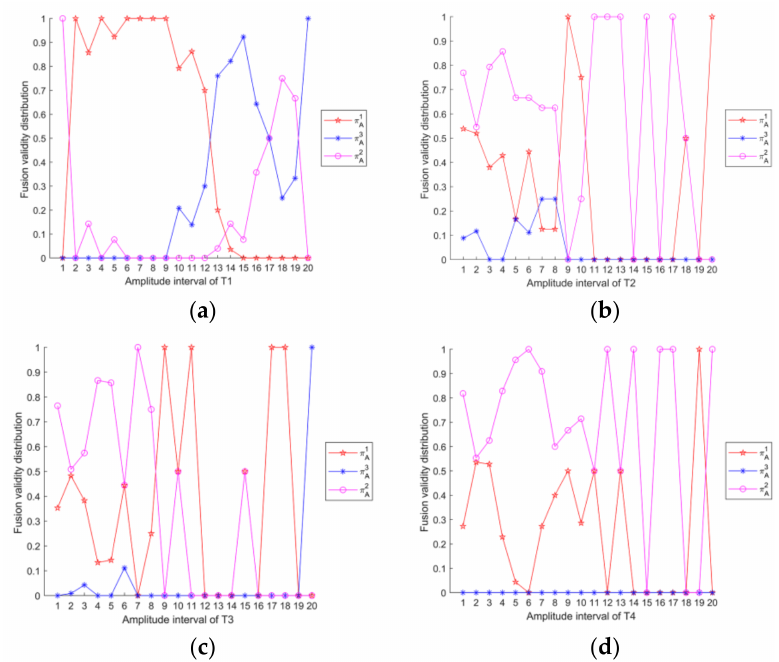
Figure 4. Fusion validity distribution of each difference feature to NSST algorithm. ( a ) difference